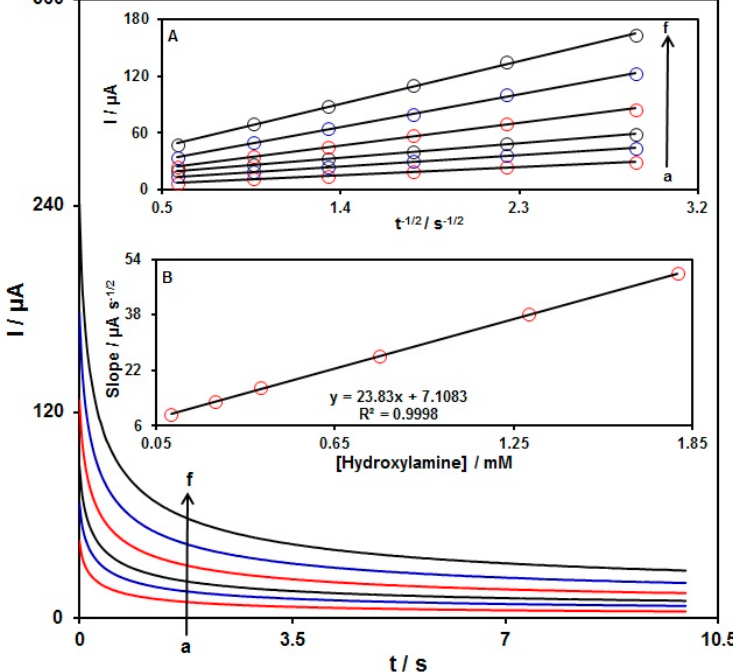
Figure 8. Chronoamperograms recorded for the PPy NTs/GSPE in 0.1 M PBS at pH = 7 with variable hydroxylamine contents. Nos. a–f: 0.1, 0.25, 0.4, 0.8, 1.3, and 1.8 mM of hydroxylamine. Insets: ( A ) ( A ) Plots of I versus t − 1/2 derived from chronoamperograms a–f. ( B ) Corresponding slopes from the chronoamperogram curves vs. the hydroxylamine